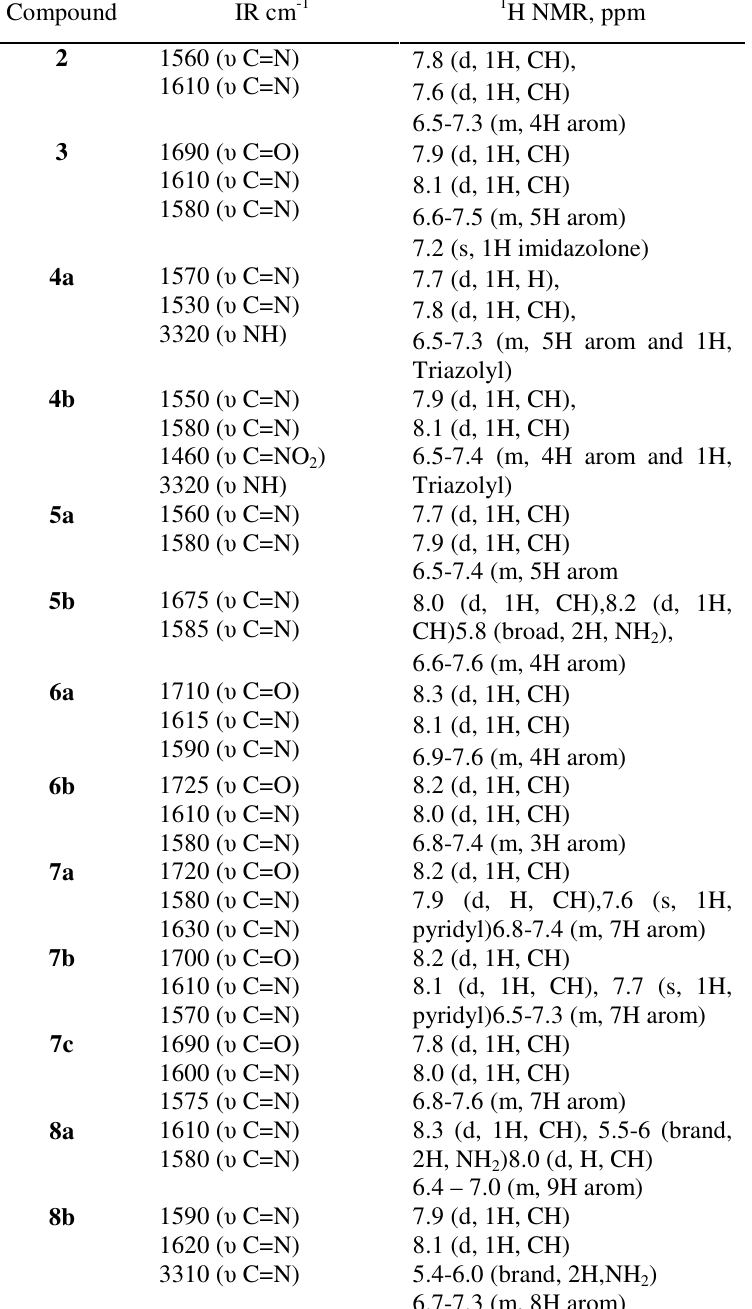
Table 2. Physical and spectral data of compounds ( 2-8 )